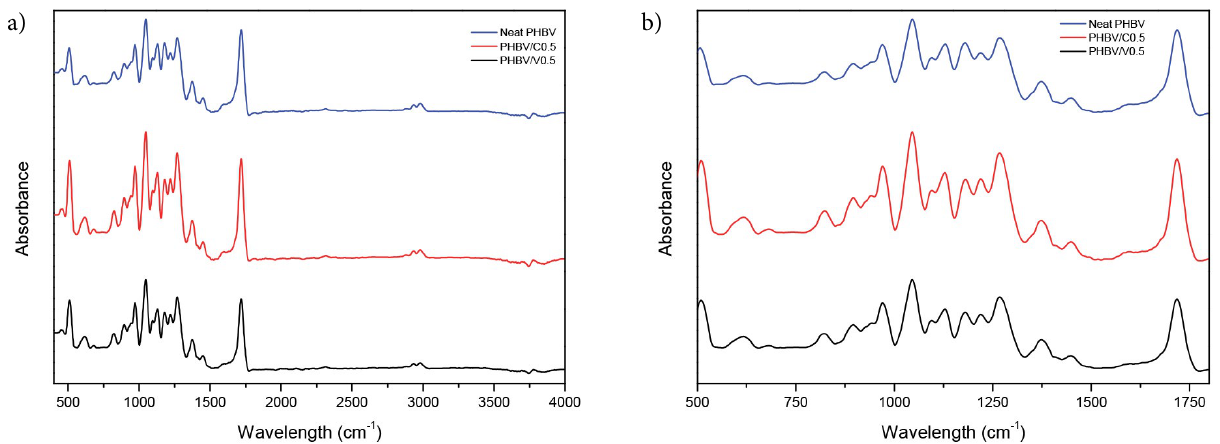
Figure 7. FT-IR spectra of the polymer composites at the (a) 400–4000 cm –1 and (b) 500–1800 region.